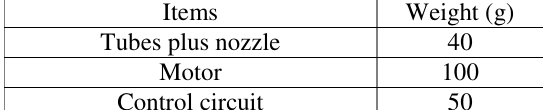
TABLE 2: PAYLOADS DETAIL OF UAV SPRAYING SYSTEM